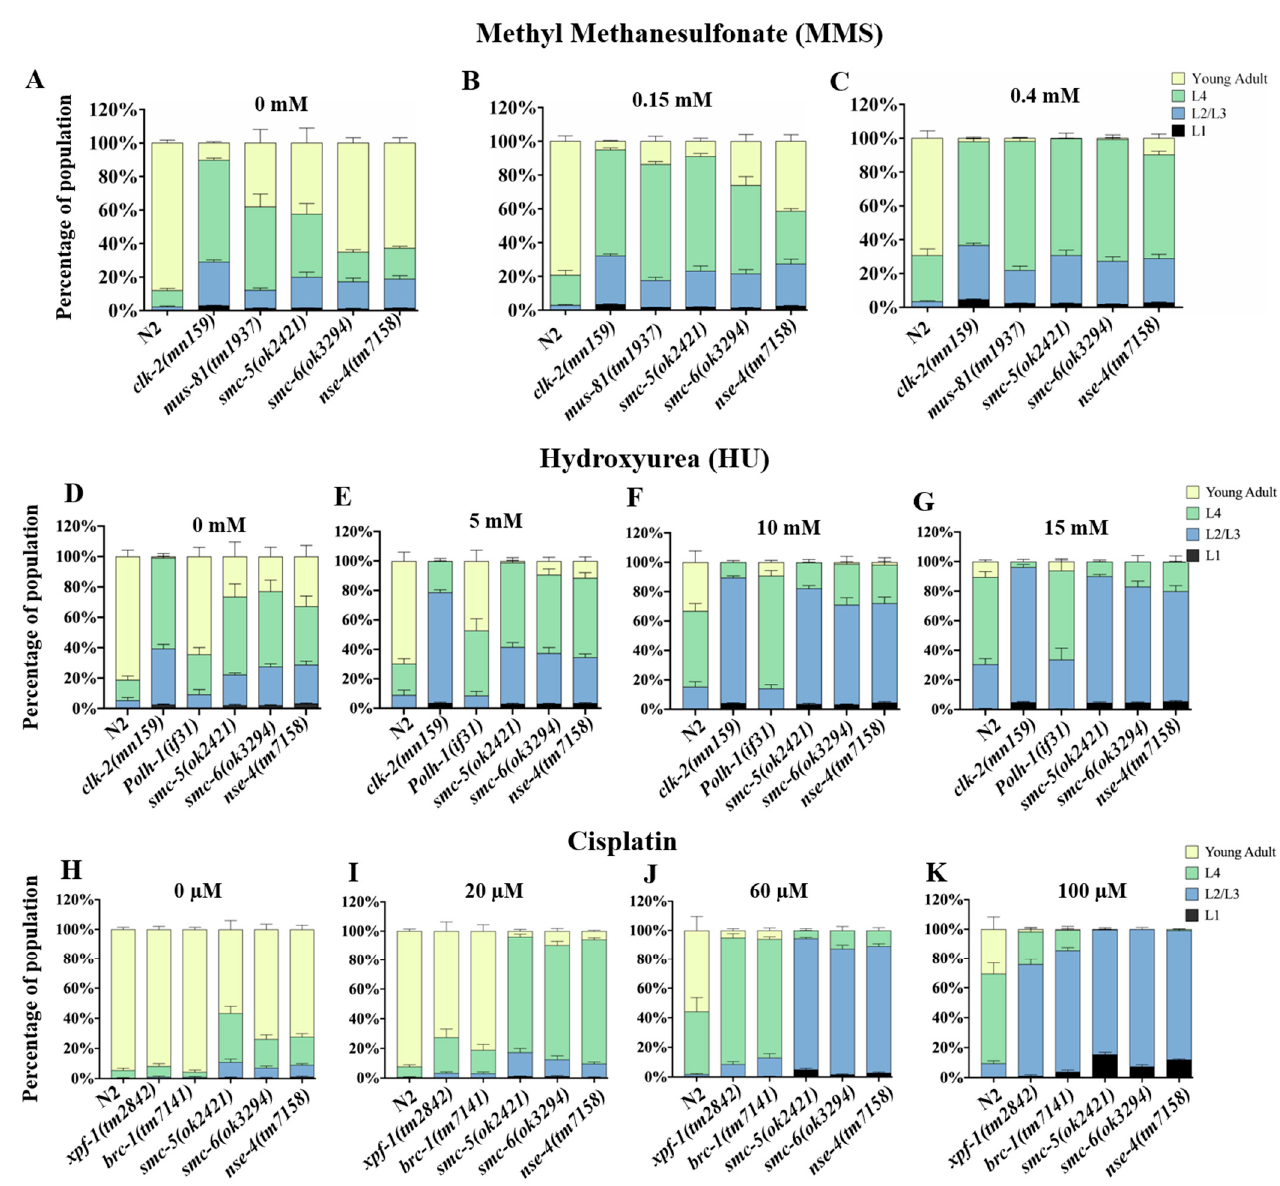
Figure 2. nse-4(tm7158) mutant exhibits developmental delay exacerbated by exposure to genotoxic stress. L1 stage worms were treated with different doses of DNA damaging agents for 16 h (20 h for HU) and allowed 48 h of recovery. ( A – C ) MMS. ( D – G ) HU, and ( H – K ) cisplatin. Results are cumulative of three independent repeats.